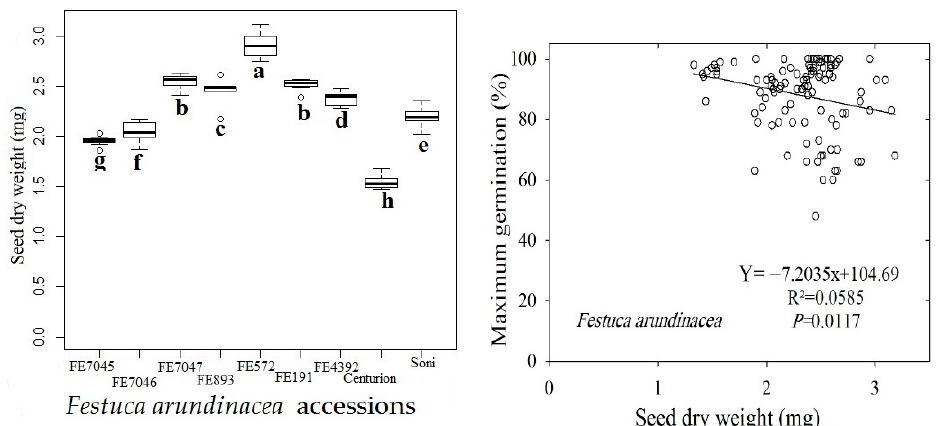
Figure 5. Box plots of seed dry weight (SDW) of the nine studied accessions of F. arundinacea ( Left ) and regression plot of the maximum germination percentage against SDW ( Right ). Same letter under the boxes indicates that means are not different after a Tukey’s HSD test ( p < 0.05).